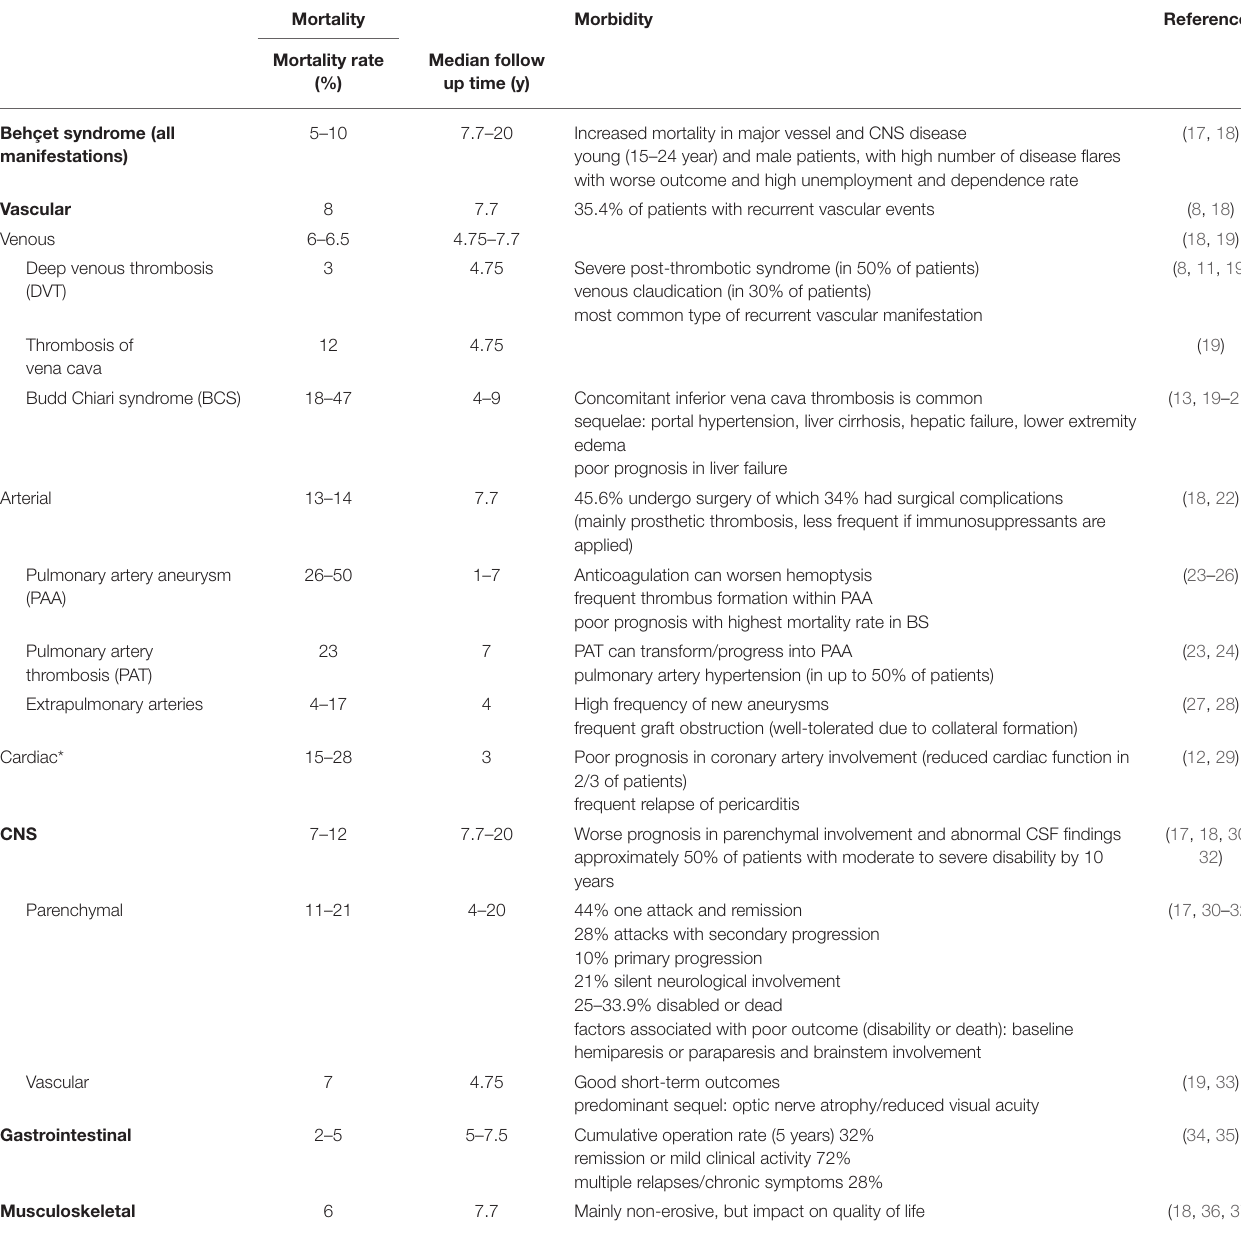
TABLE 1 | Overview of morbidity and mortality of different organ manifestations in BS.